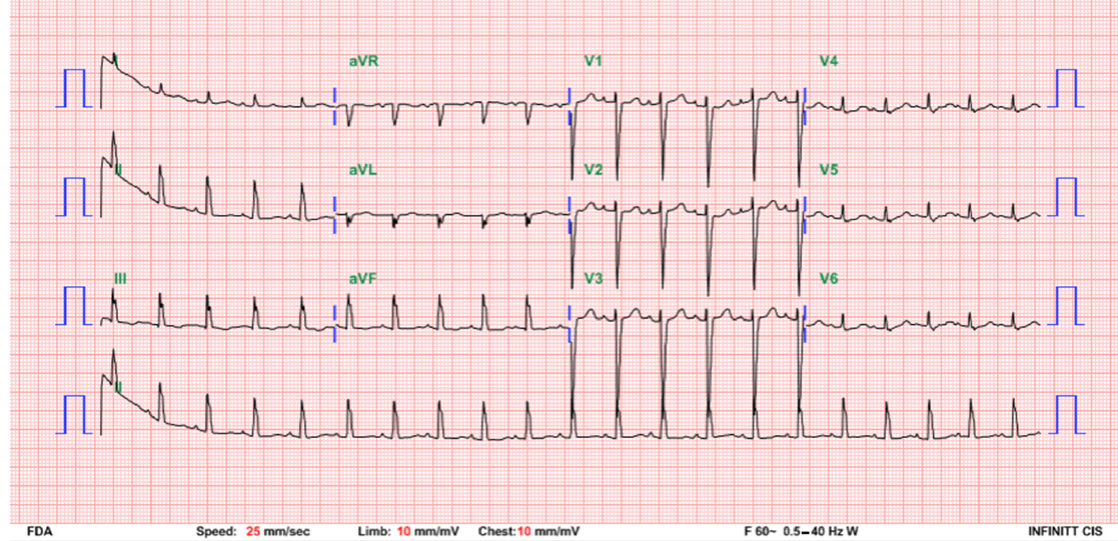
Figure 3. ECG at 5 days of age indicating a normal sinus rhythm with a heart rate of 125 bpm.